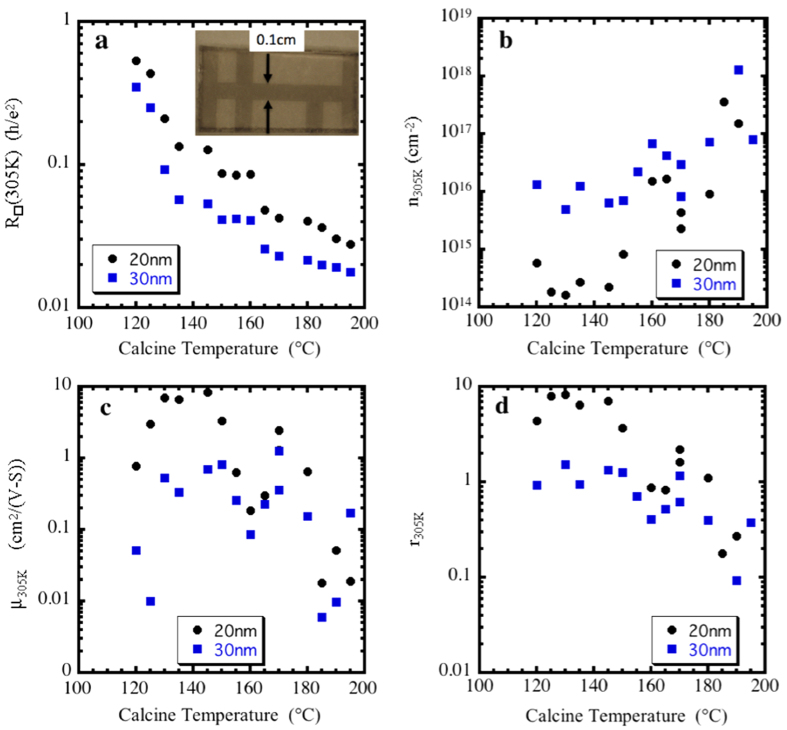
Room-temperature transport properties of RuO2 nanosheets.(a) R/◻ (plotted in units of quantum resistance, h/e2); (b) carrier concentration; (c) mobility; and (d) the “rs” parameter (labeled r305K) as a function of calcination temperature for the 20-nm (on SiO2 substrate) and 30-nm (on Al2O3 substrate) thick RuO2 nanosheets. Inset (a) geometry of the laser-patterned films.